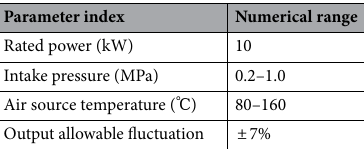
Table 1. Operating condition parameters of Roots waste heat power generation device.